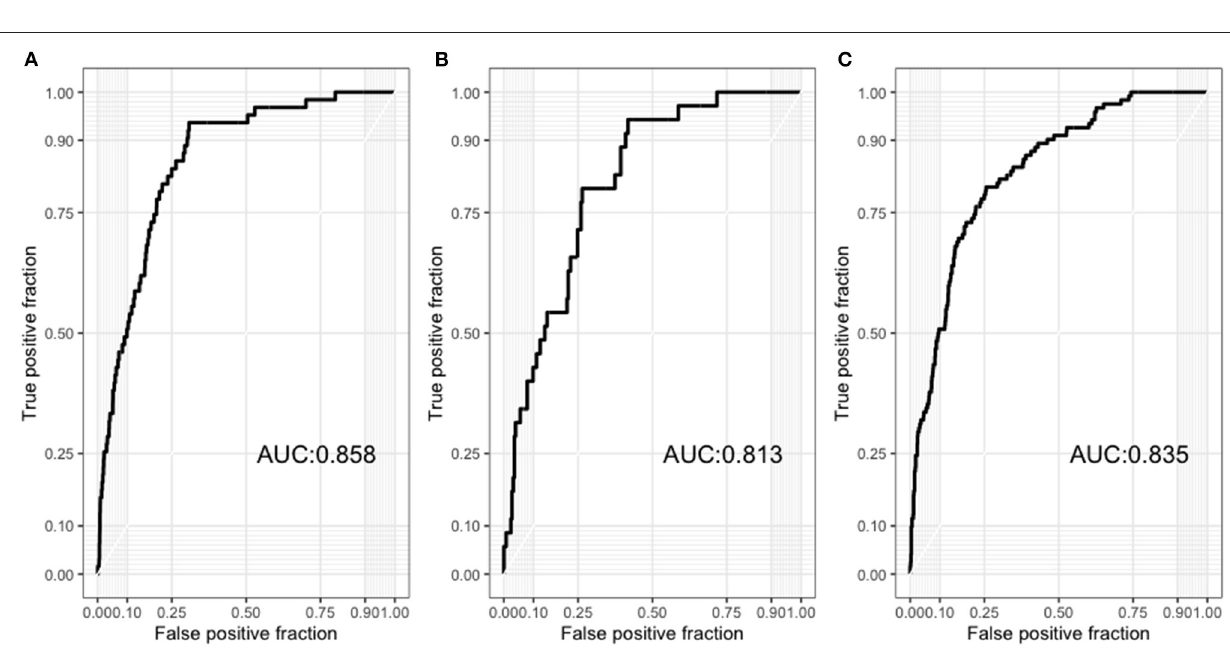
can achieve good performance and even outperformed the RSS score for mortality